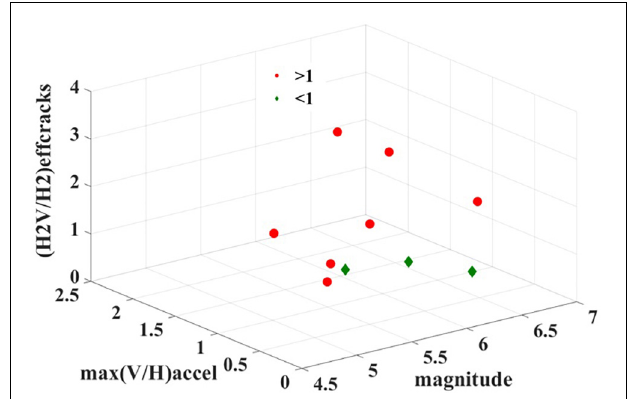
FIGURE 8 | Ratio of cracks generated under the H2V analyses and H2